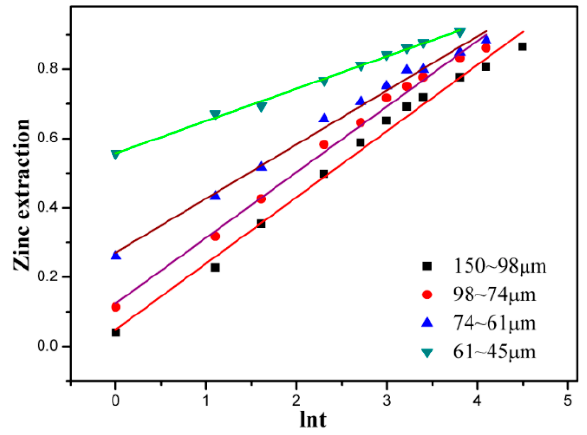
Figure 8. Plot of zinc extraction versus ln t for different particle sizes.